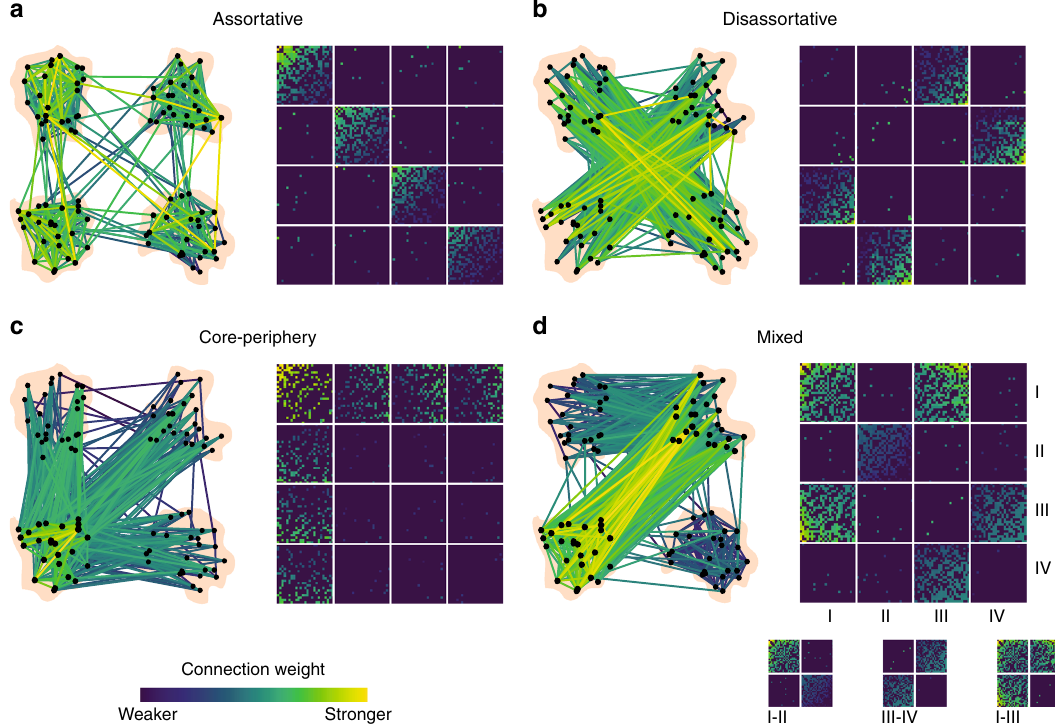
Fig. 1 Community structure types. Networks can exhibit different types of meso-scale structure. a Assortative communities are sub-networks whose internal density of connections exceeds their external density. b Disassortative (multi-partite) communities are sub-networks where connections are made preferentially between communities so that communities ’ external densities exceed their internal densities. c Core-periphery organization consists of a central core that is connected to the rest of the network and then peripheral nodes that connect to the core but not to one another. d These meso-scale structures can be present simultaneously in the same network. For example, communities I – II interact assortatively, III – IV interact disassortatively,